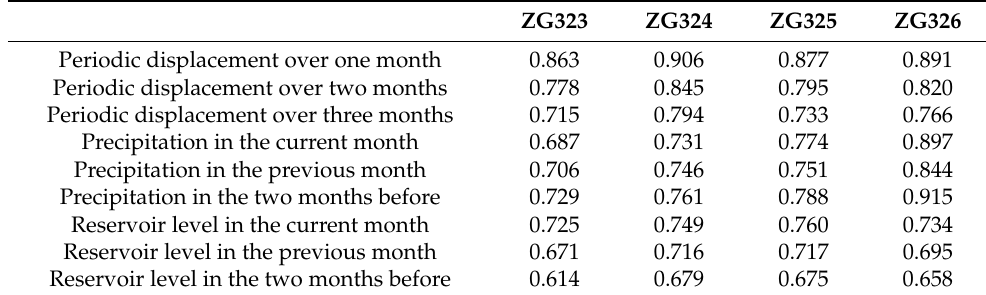
Table 4. Input data for the approaching of the periodic displacement and the GRA between inducing factors and periodic displacement.